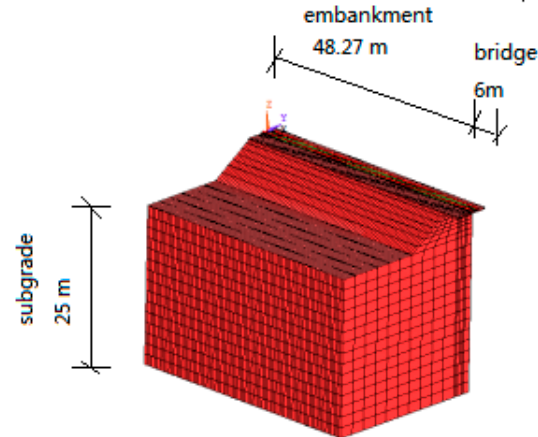
Figure 6. Finite element numerical model of track subgrade in road bridge transition section.